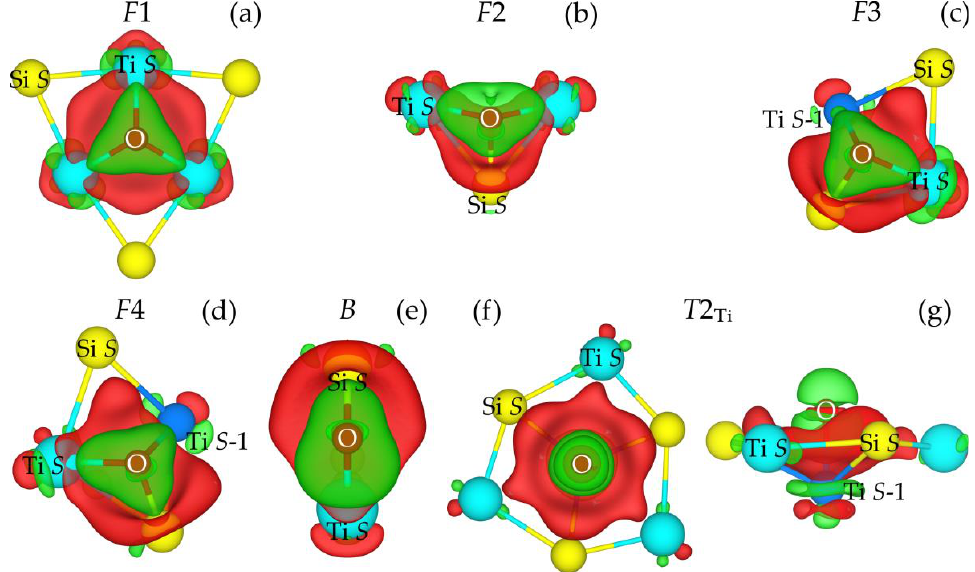
Figure 5. Distribution of charge density difference ( ∆ ρ = ρ O + ρ Ti surface with oxygen adsorbed in F 1 ( a ), F 2 ( b ), F 3 ( c ), F 4 ( d ), B ( e ), T 2 Ti ( f , g ). Top view ( a – f ) and side view ( g ) are given. Charge depletion and accumulation regions are shown by red and green colors, respectively.